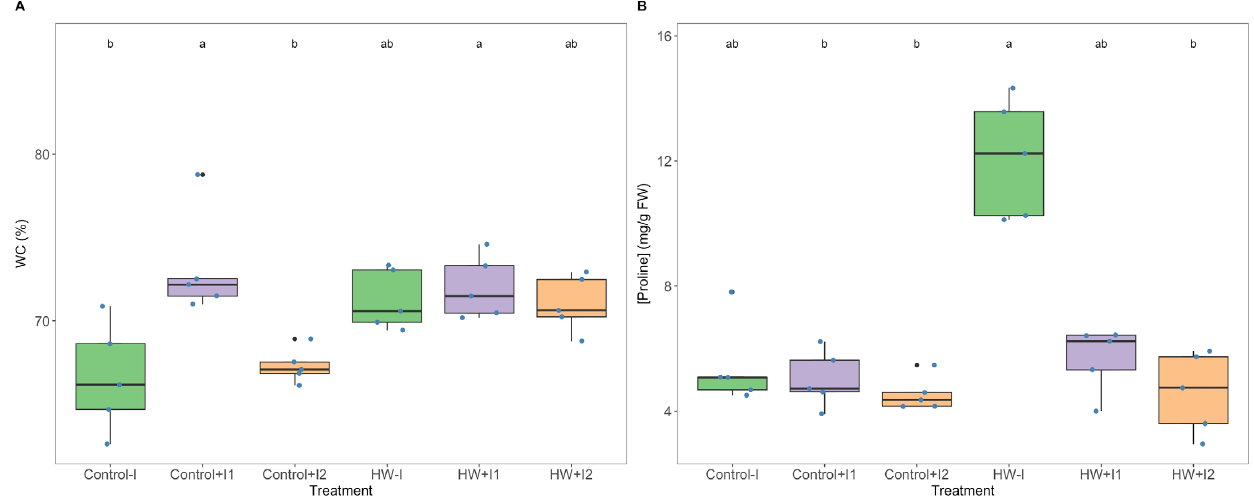
Figure 7. Leaves ( A ) water content (WC) and ( B ) proline concentrations of non-inoculated ( − I) and marine PGPR consortia 1- and 2-inoculated (+I) Vitis vinifera , under normal (control) thermal regimes and exposed to the heatwave (HW) (average ± standard deviation, N = 5, letter denotes significant differences at p < 0.05).